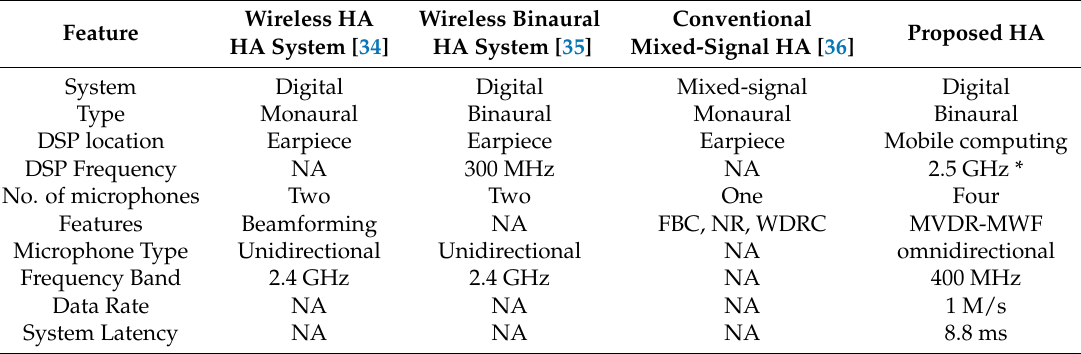
Table 2. Architectural level comparison of Hearing Aids (HA). MVDR, Minimum Variance Distortion Response method and Multichannel Wiener Filtering.